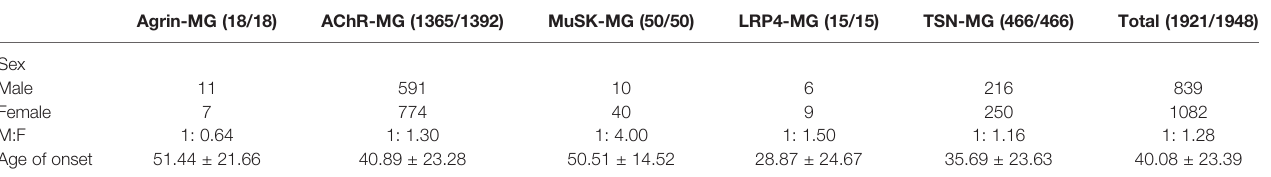
TABLE 1 | Age and sex distribution of MG serological subgroups.